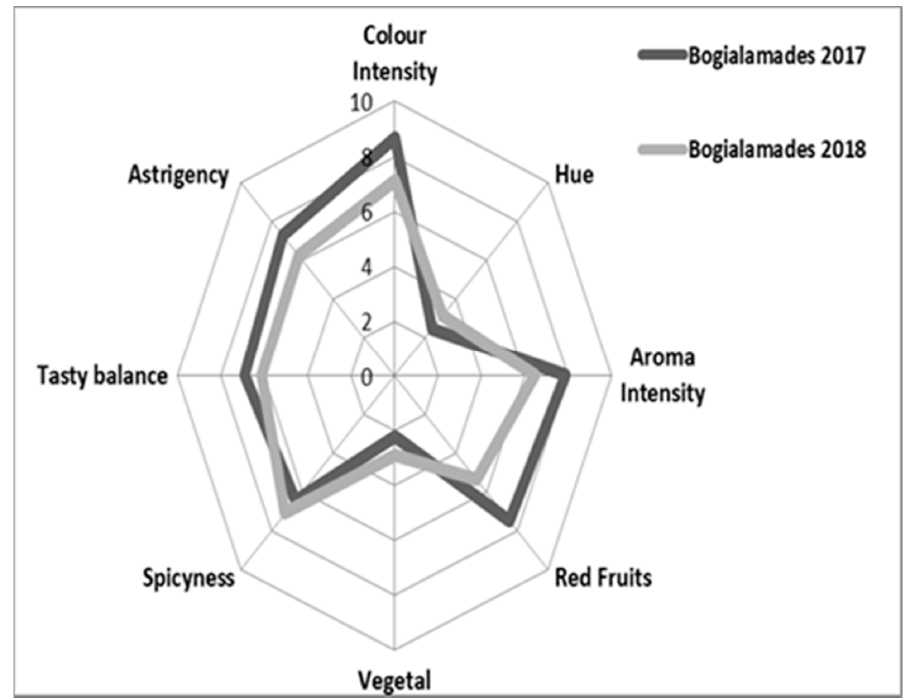
Figure 8. Sensory profile (Spider Diagram) of “Bogialamades” wines in two consecutive years, outlined by a group of professional tasters from the Laboratory of Enology and Alcoholic Beverages of the Agricultural University of Athens. The centers of the diagrams represent the lower values with the tension of each attribute increasing to an intensity of the digit 10 at the perimeter.